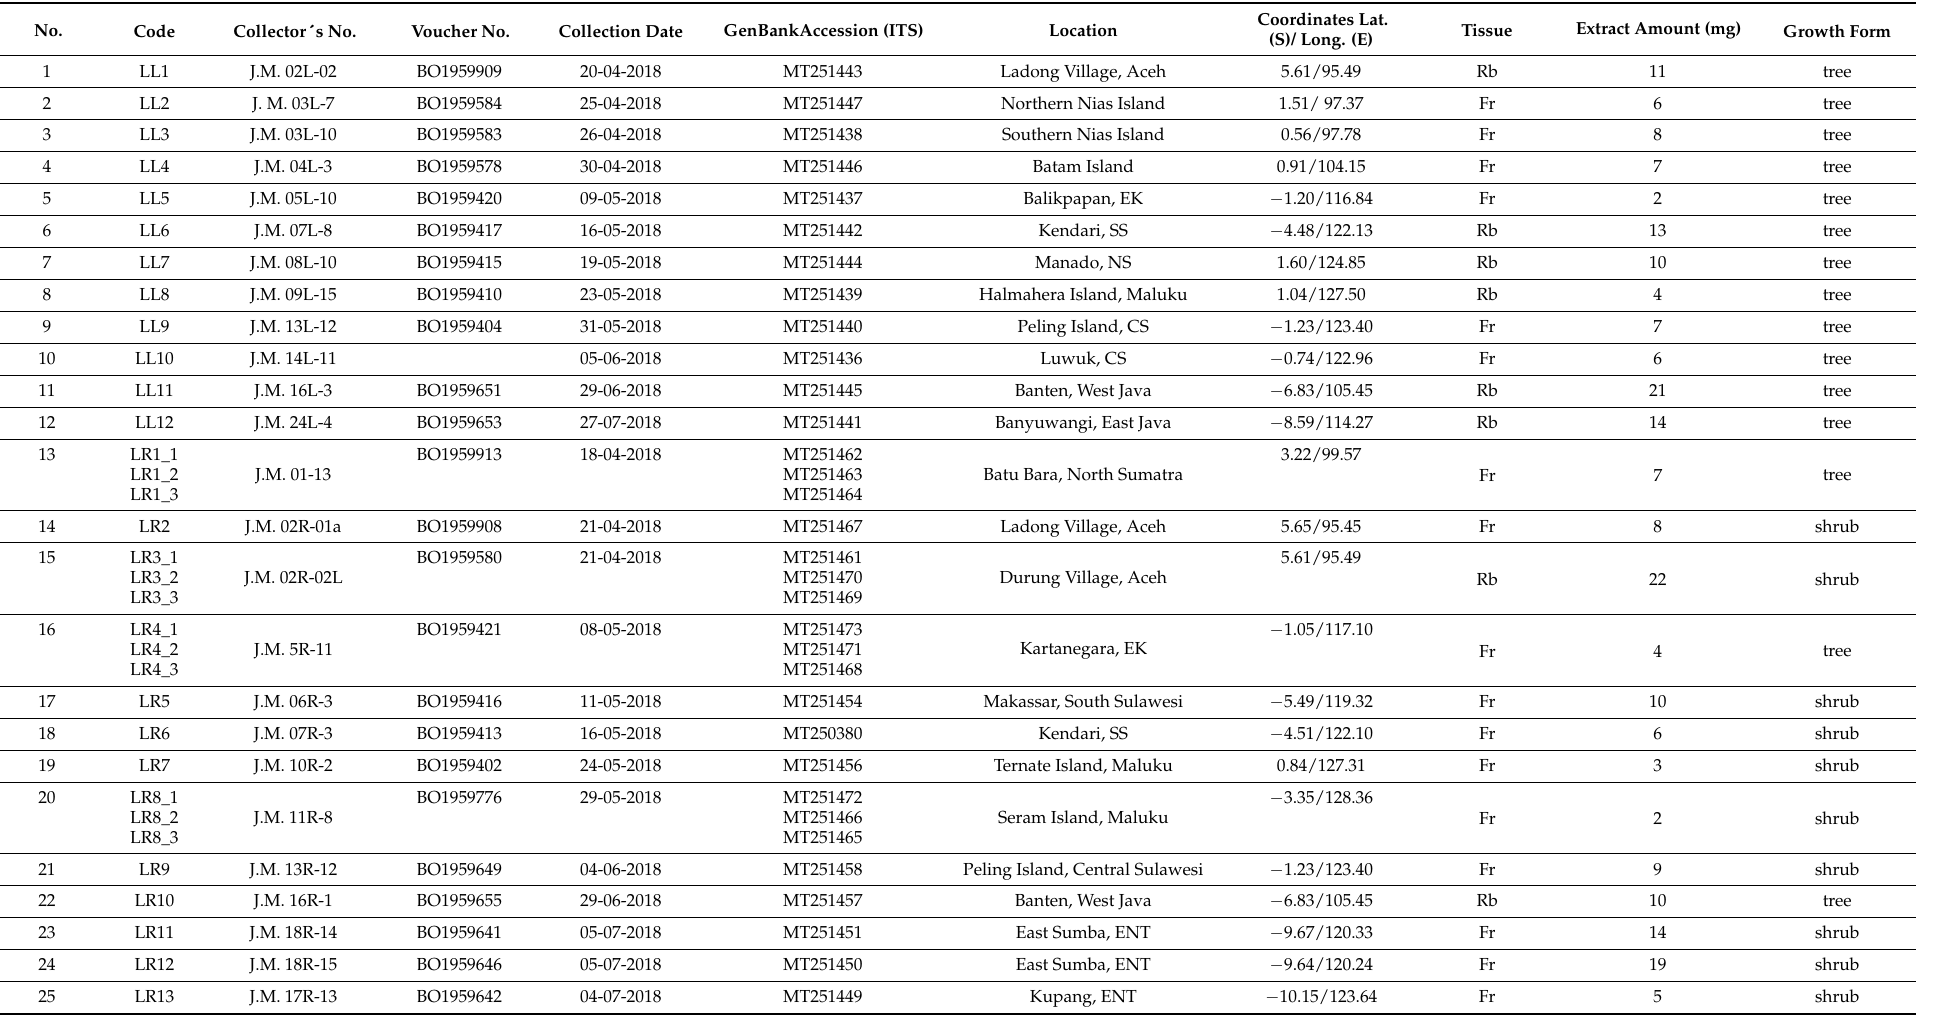
Table 1. Samples from L. littorea (no. 1–12) and L. racemosa (no. 13-31) used for phytochemical and DNA analyses. Abbreviations: J.M. = Jeprianto Manurung, Fr = Fine root, Rb = Root bark, NS = North Sumatra, EK = East Kalimantan, SS = Southeast Sulawesi, NS = North Sulawesi, CS = Central Sulawesi, ENT = East Nusa Tenggara. No. Code Collector ´ s